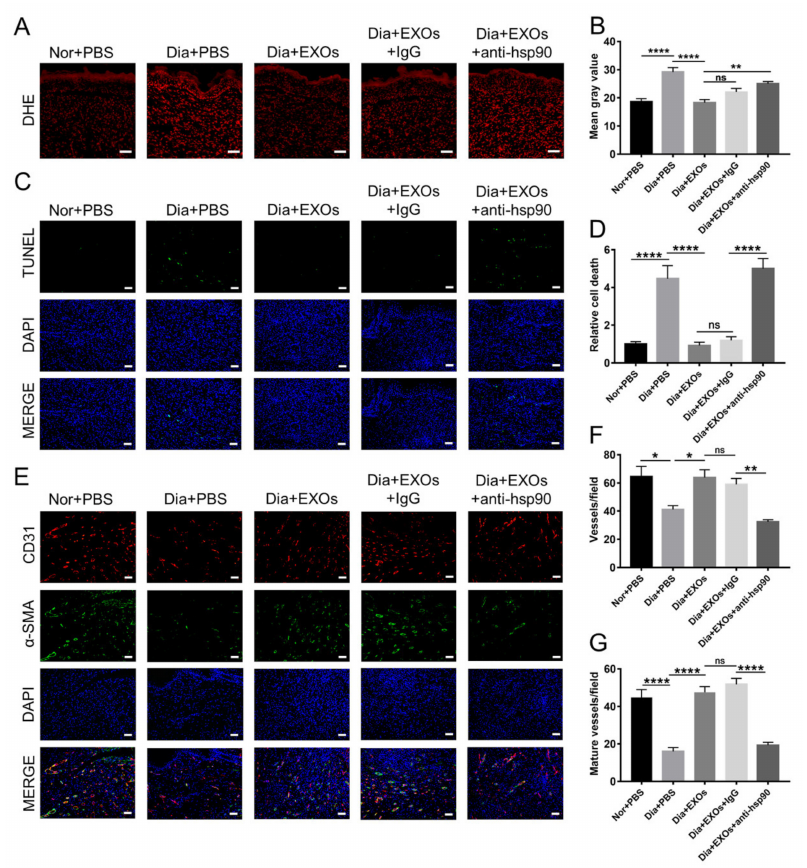
Figure 7. ADSC-EXOs enhanced neovascularization and reduced cell death in diabetic wounds via eHSP90. ( A ) Representative DHE fluorescent images of the wound section in each group; scale bar: 50 µ m. ( B ) Quantitative analysis of the mean fluorescence intensity in ( A ). ( C ) TUNEL staining analysis of the apoptotic level of wound cells in each group; green color represents the dead cells, and blue color represents the cell nucleus; scale bar: 200 µ m. ( D ) Quantification of the apoptotic rate shown in ( C ). ( E ) Immunofluorescence staining of CD31 (red) and α -SMA (green) in the wound sections on day 13 post operation; scale bar: 200 µ m. ( F ) Enumeration of newly formed vessels stained with red color. ( G ) Enumeration of mature vessels co-stained with red and green colors. n = 7. * p < 0.05, ** p < 0.01, **** p <